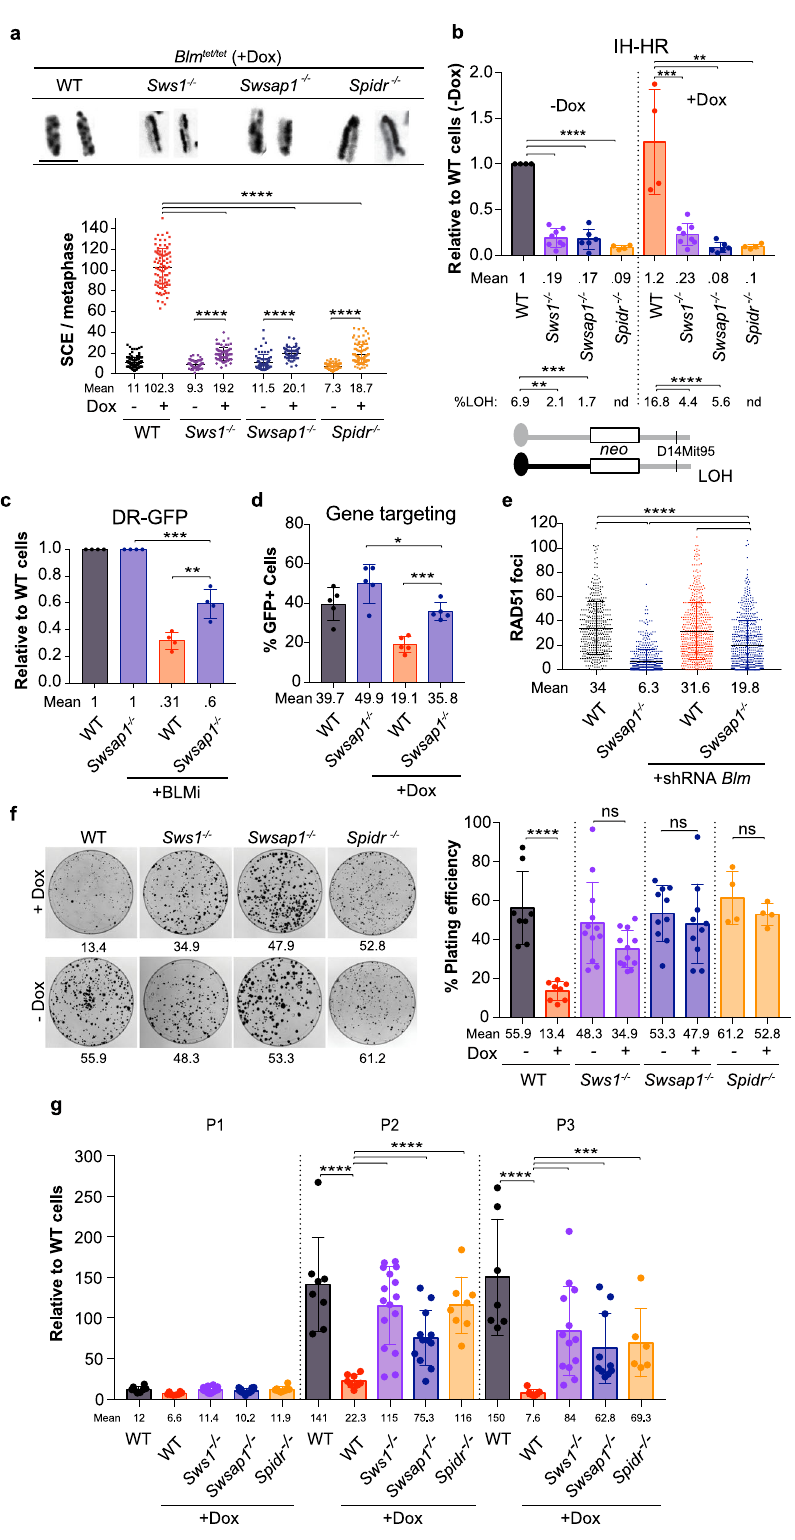
HDR is critical to repair DNA damage arising during neural development, such that in HDR mutant apoptosis of proliferating cells is observed from early to mid-gestation in the brain 50,51 . Swsap1 − / − embryos have a small increase in apoptosis in the proliferative ventricular zone (VZ) of the forebrain compared to controls at both E12.5 and E15.5 (Fig. 4b, c and